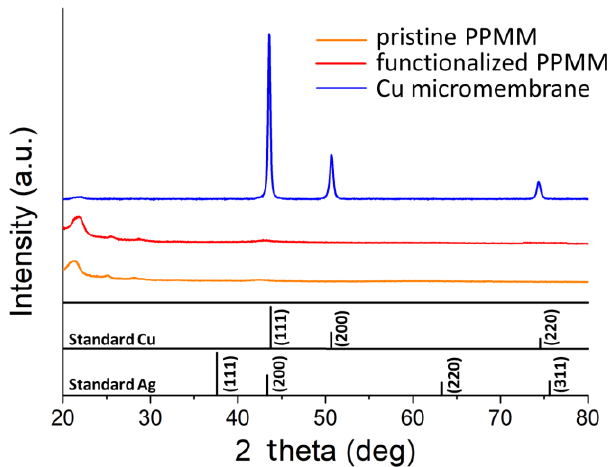
Figure 5. The XRD patterns for pristine PPMM, functionalized PPMM, and Cu micromembrane, as well as standard JCPDS of Cu (04-0836) and Ag (04-0783) for comparison purposes.